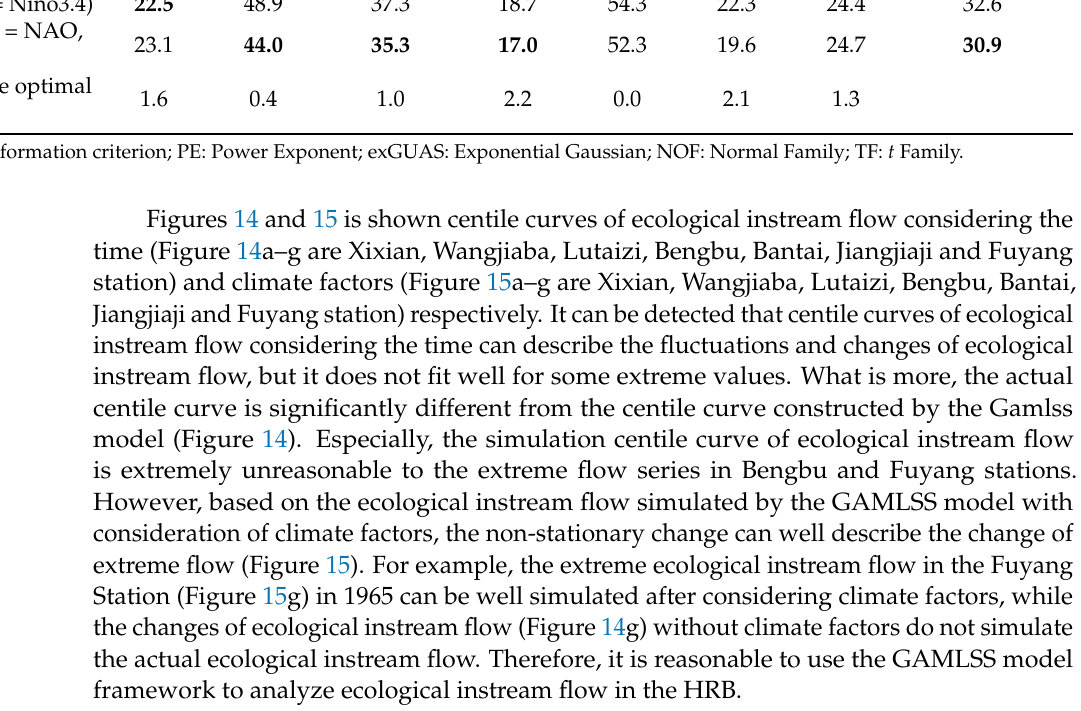
Figure 15. Centile curves of nonstationary ecological instream flow with climate factors. 5. Discussion Many people use this method to discuss runoff and biodiversity [1,3,56]. Zhang et al. [1,3] discussed the evaluation of ecological discharge change in the Yellow River Basin and the Pearl River Delta based on hydrological changes. The ecological instream flow commonly showed a decreasing trend. The ecological instream flow indicators showed a decreasing trend in the mainstream of the Huai River except for Xixian station (Figure 10), illustrating that the contradictions between socio-economic, agricultural water consump- tion and ecological water demand are becoming increasingly prominent (Figure 16e). The total irrigated area of Henan and Anhui provinces has increased from 3.6 × 10 4 km 2 in 1991 to 3.79 × 10 4 km 2 in 2016 in the HRB, and the total agricultural population has increased from 83.421 million to 97.518 million [57]. Meanwhile, Figure 16 shows that land cover changed between the periods of 2000 and 2015 has shown that grassland from 3.20% to 3.24%, water bodies from 2.71% to 2.89%, and the artificial surfaces area has increased from 11.73% to 12.91%, but forest area has decreased from 10.86% to 10.83% (Figure 16a– d). The riverbed ratios of the two stations of Pantai and Fuyang are 1 and 1/3000 respec- tively, the annual runoff depth is 24.6 mm and 15.7 mm, and the water resources are rel- atively small. has The maximum farmland transforming to artificial surfaces occurred in